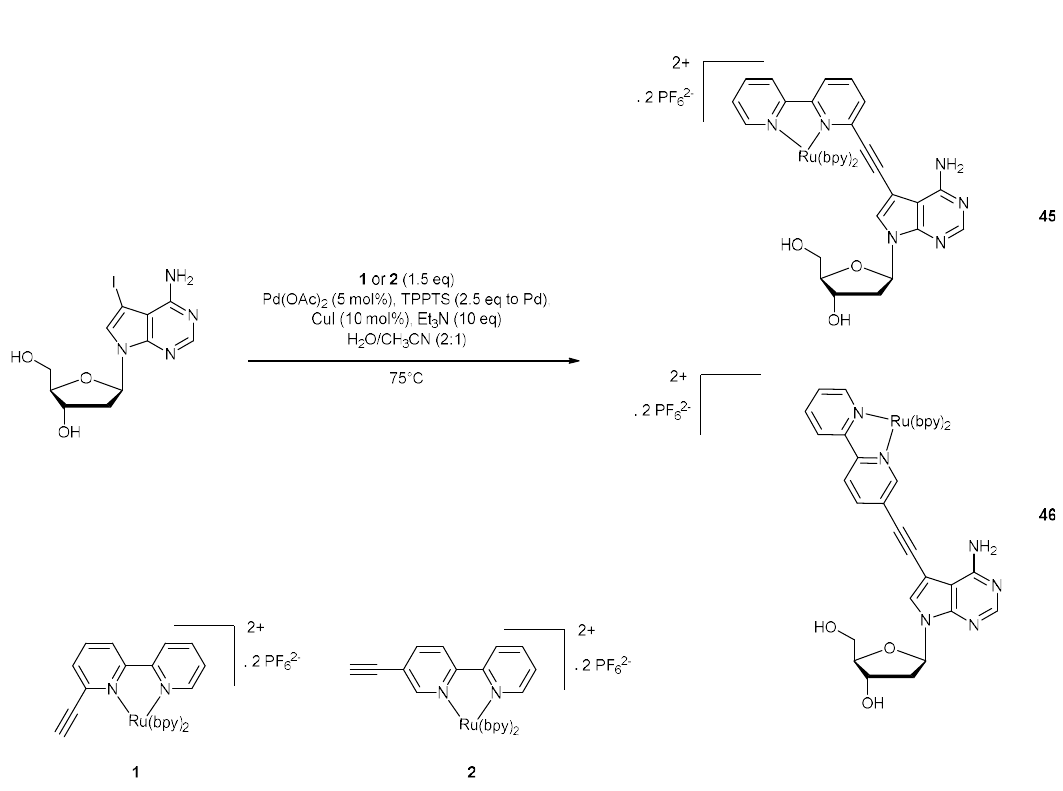
Figure 19. Synthetic pathway for the preparation of nucleoside triphosphates 45 , 46 [160].